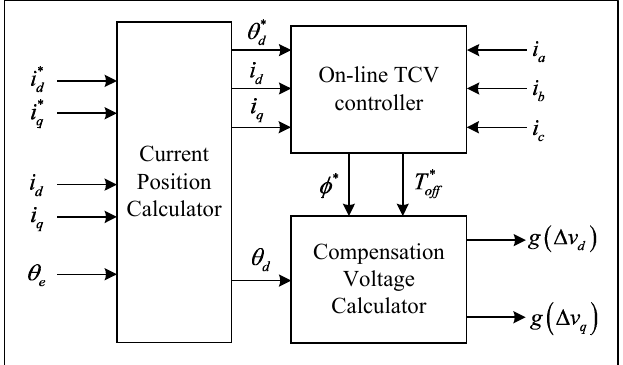
Figure 19. The specific block diagram of Figure 18a.